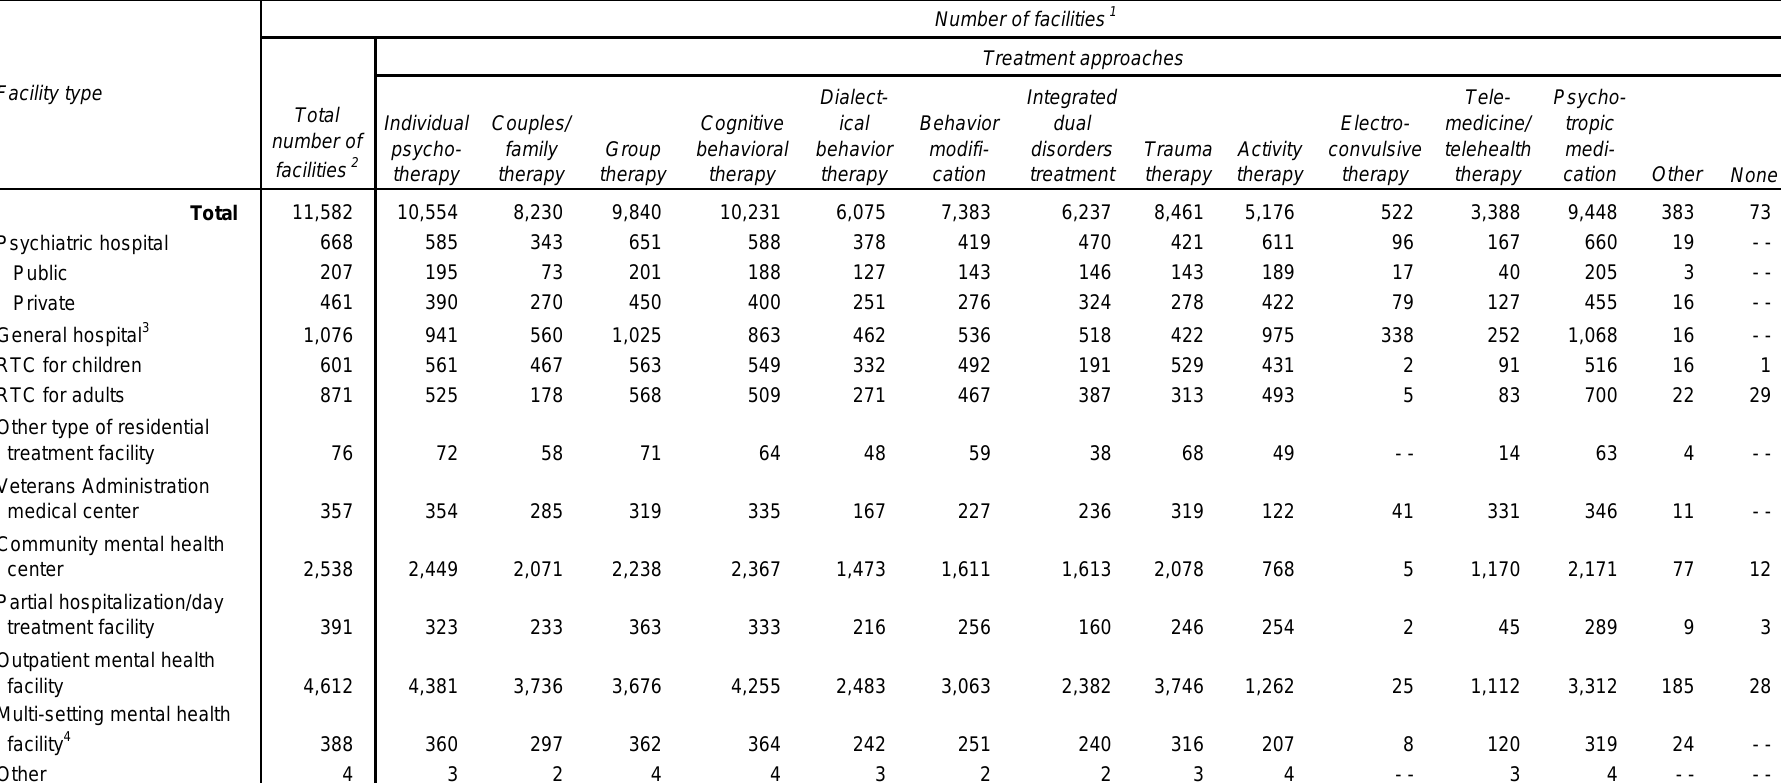
Table 2.3a. Mental health treatment facilities offering various treatment approaches, by facility type: Number,